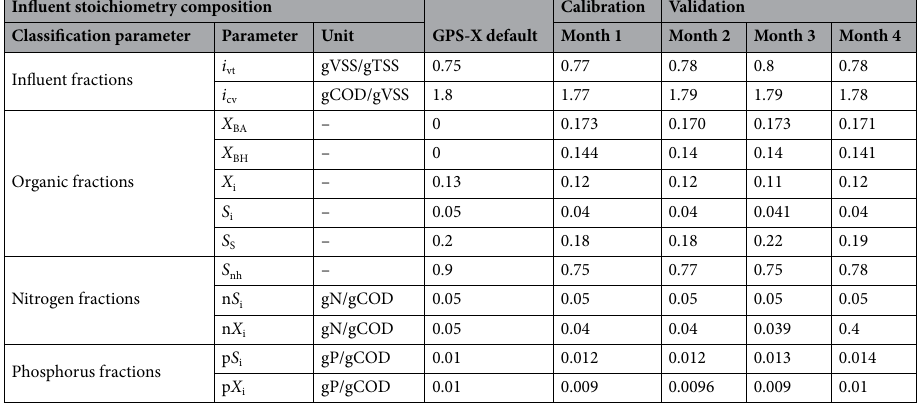
Influent stoichiometry composition